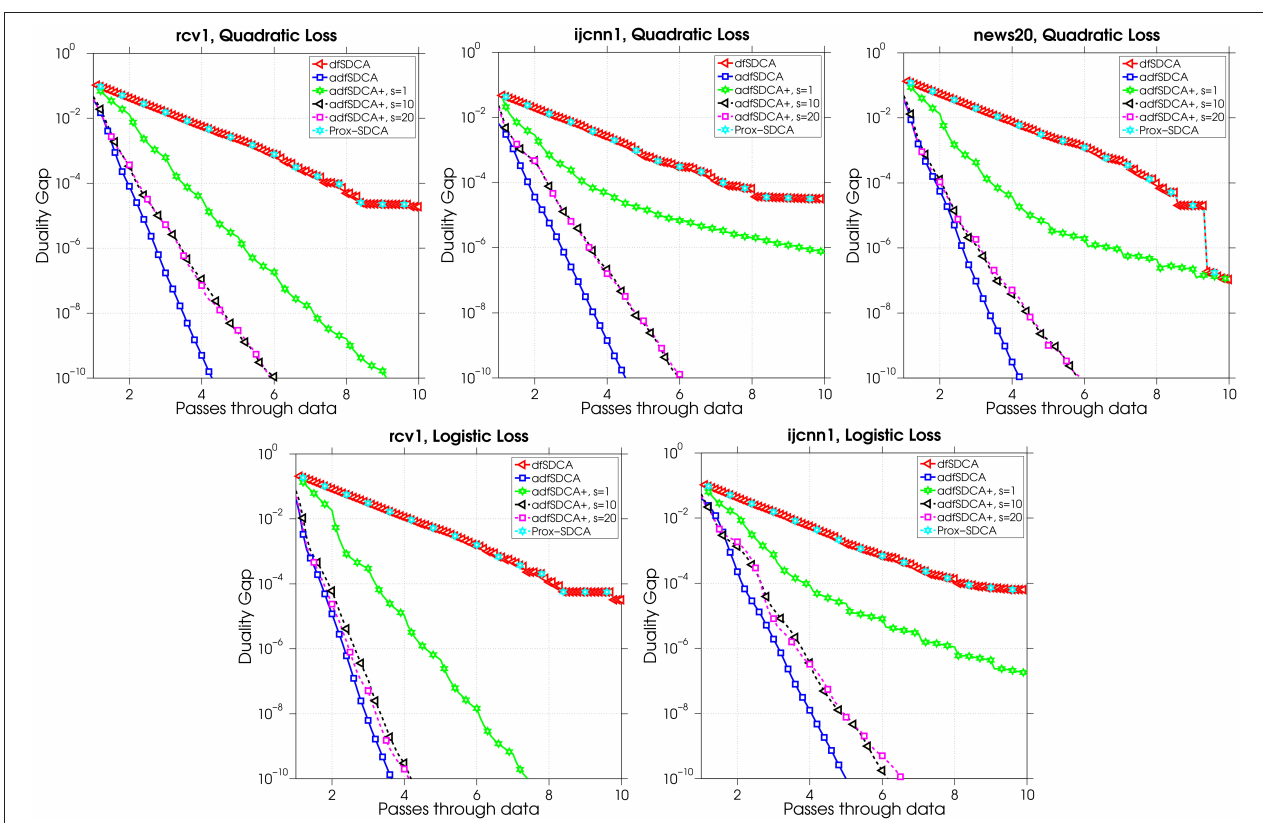
FIGURE 2 | A comparison of the number of epochs vs. the duality gap for the various algorithms.